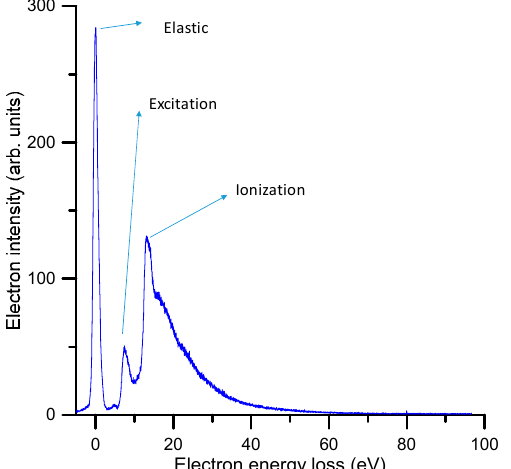
Figure 1. Averaged energy loss (0–100 eV) spectrum for 100 eV incident electron collisions with pyridine, as measured with our linear transmission apparatus [7].